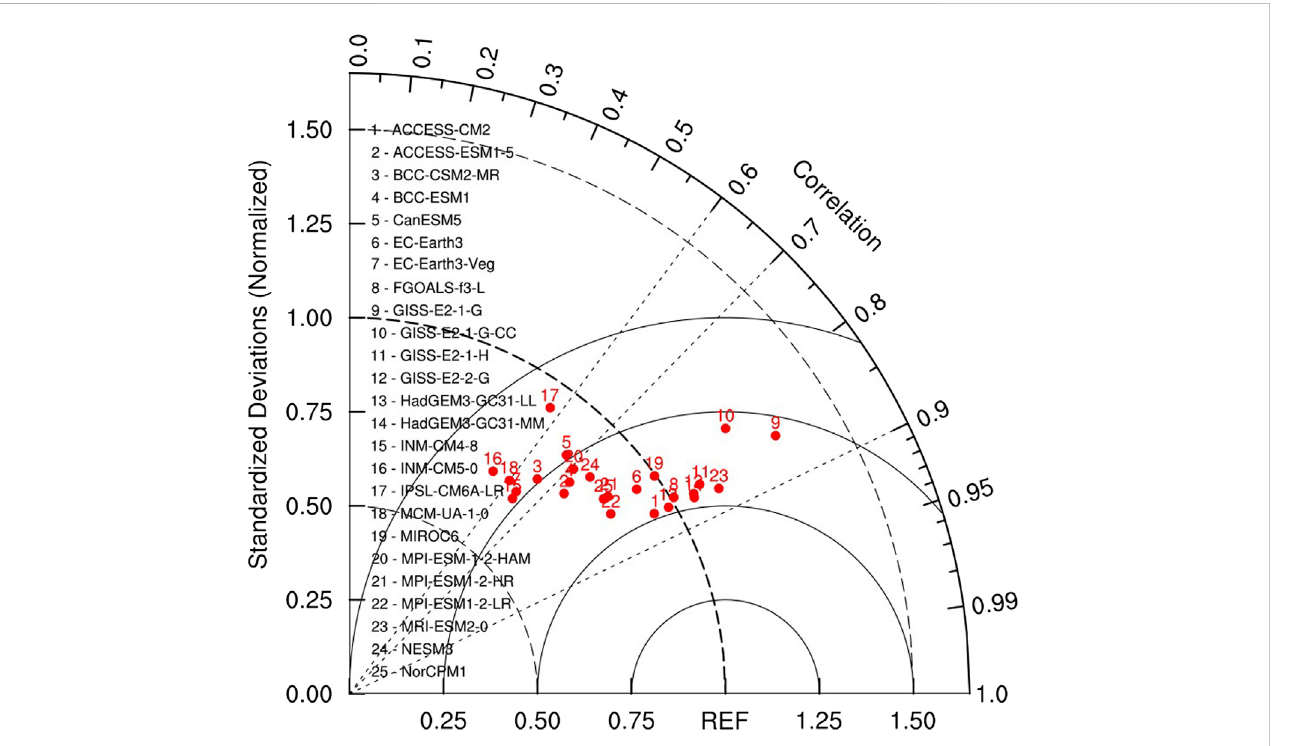
FIGURE 10 Taylor diagram of the NAD pattern. Each numbered dot in the diagram represents a single model. The term “ REF ” on the horizontal axis refers to the reference point. Black dashed lines and arcs indicate the correlation coef fi cient and the ratio of standard deviations between modeled and observed NAD patterns, respectively. Black solid arcs show the centered root mean square difference which is equal to the radical distance from the reference